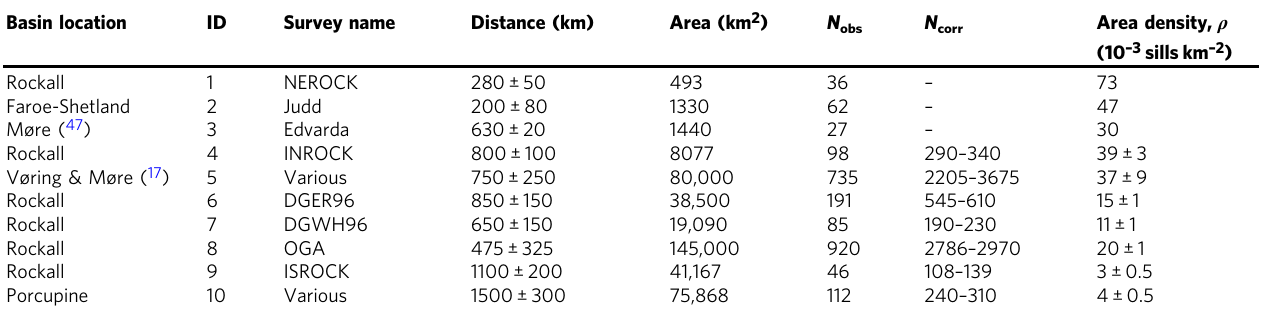
Table 2 Sill intrusion density observations.